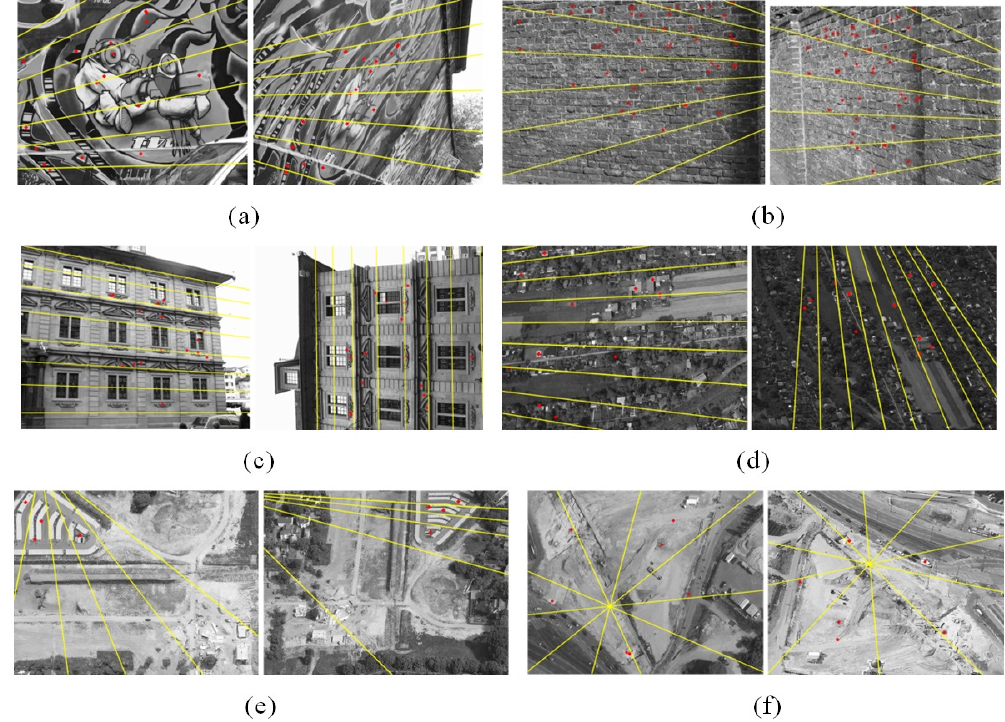
Figure 12. ( a )–( f ) Red points show the matching results of the Mata’s method with groups of stereo images. The yellow lines represent the epipolar lines estimated from matching points.